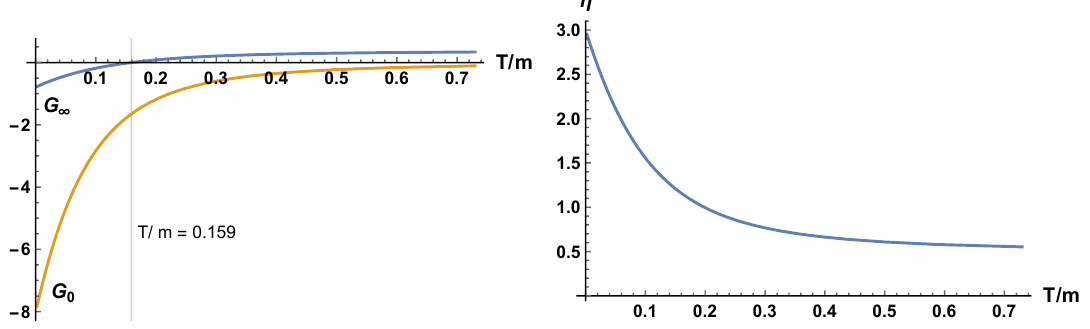
Figure 15 . Left: the static and in(cid:12)nite frequency elastic moduli G 0 and G 1 in function of T=m . Right: the shear viscosity in function of T=m . The asymptotic value at T=m ! 1 is exactly s= 4 (cid:25) . The results for the shear correlator (4.26) are shown in (cid:12)gure 14. As expected the real part of the correlator asymptotes a constant value at in(cid:12)nite frequency which indeed